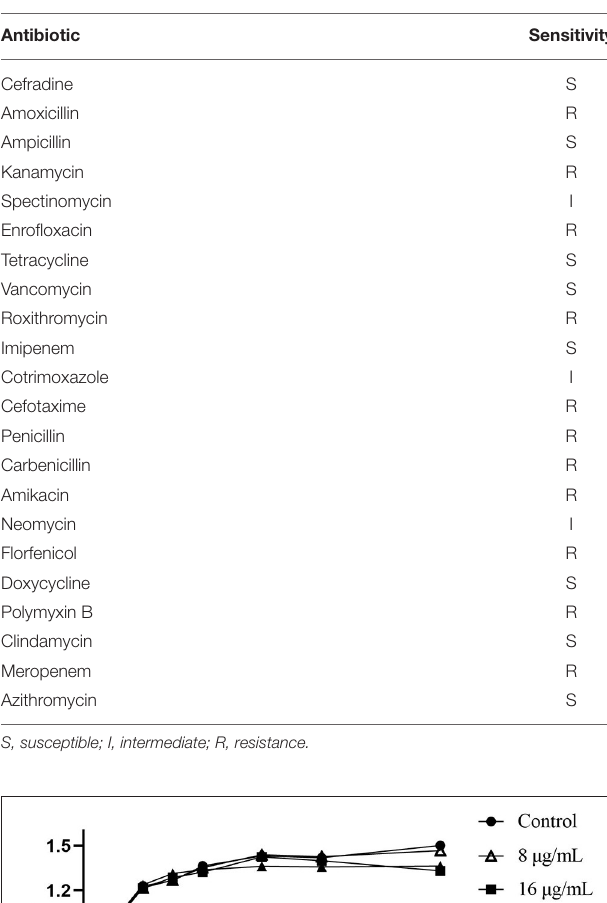
and normal binary fission ( Figures 2C,E ). Thymol treated cells showed damage, rough edges, blurred boundaries, and uneven staining ( Figure 2D ). After 16 h, the cell damage intensified, with